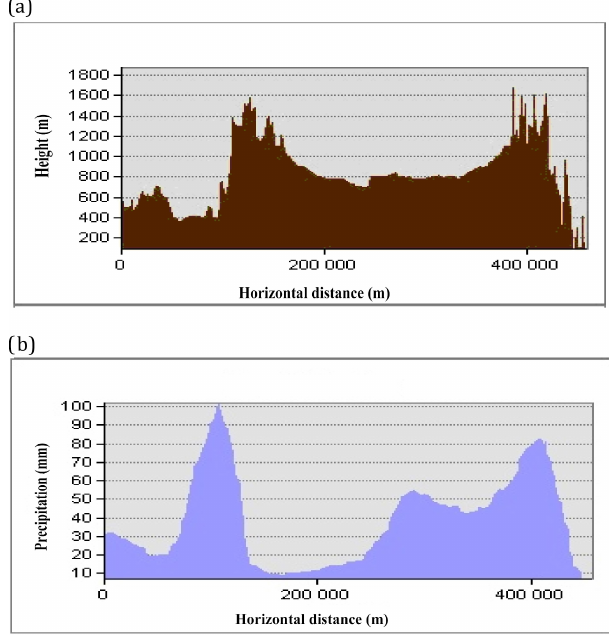
Figure 7. Topographic (a) and precipitation (b) profiles along a south–north-oriented line crossing the Gredos